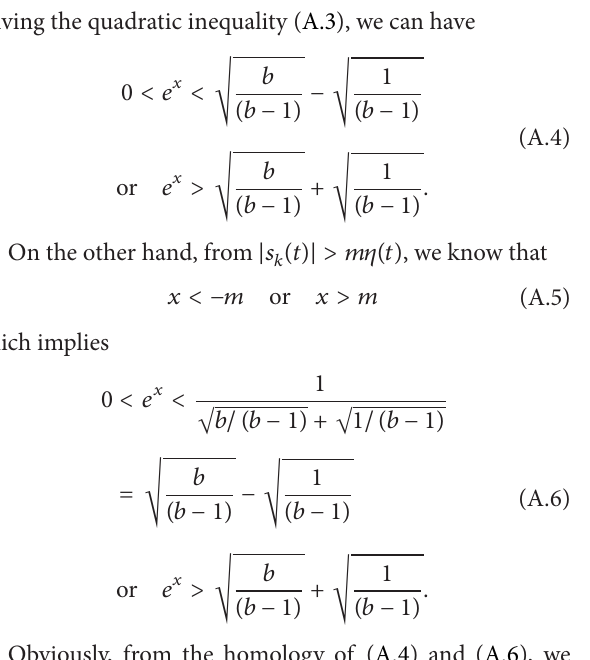
Figure 12: System output 𝑦 on 𝑦 𝑑 in Case 3.